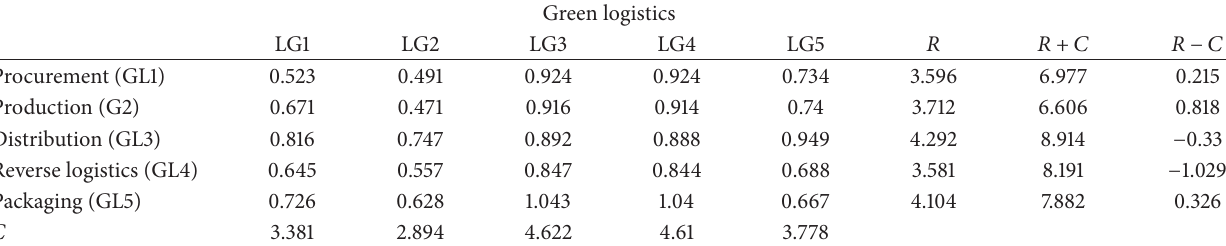
Table 6: Total-relation matrix for elements of green